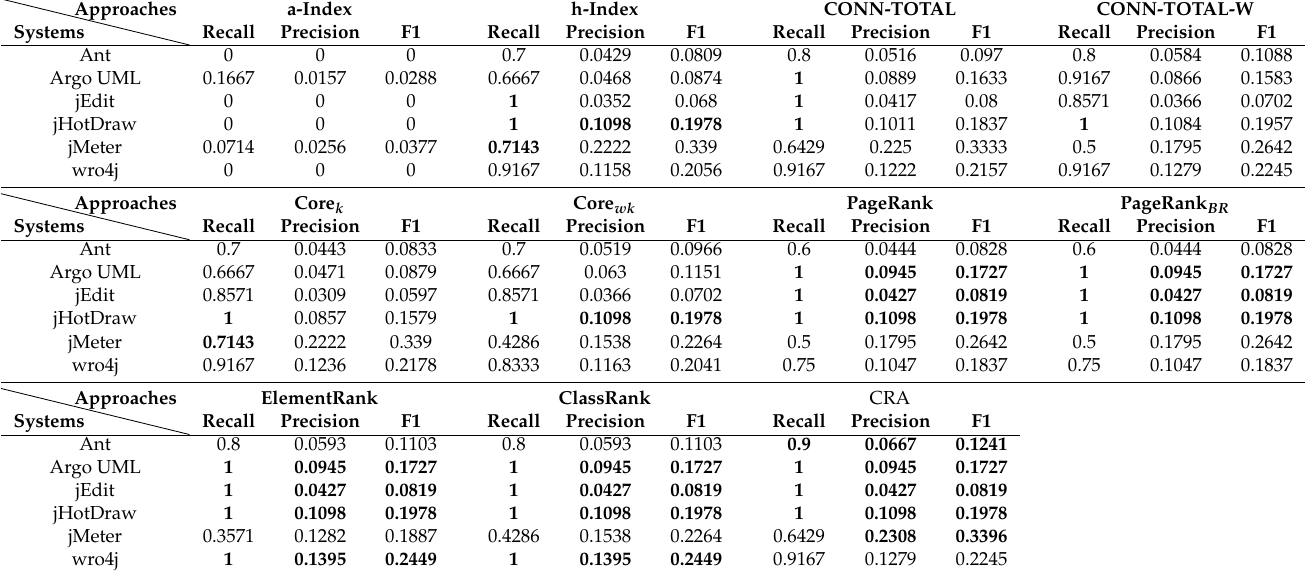
Table 6. Recall, precision, and F1 comparison of CRA against other baseline approaches (cut-off = 15%).